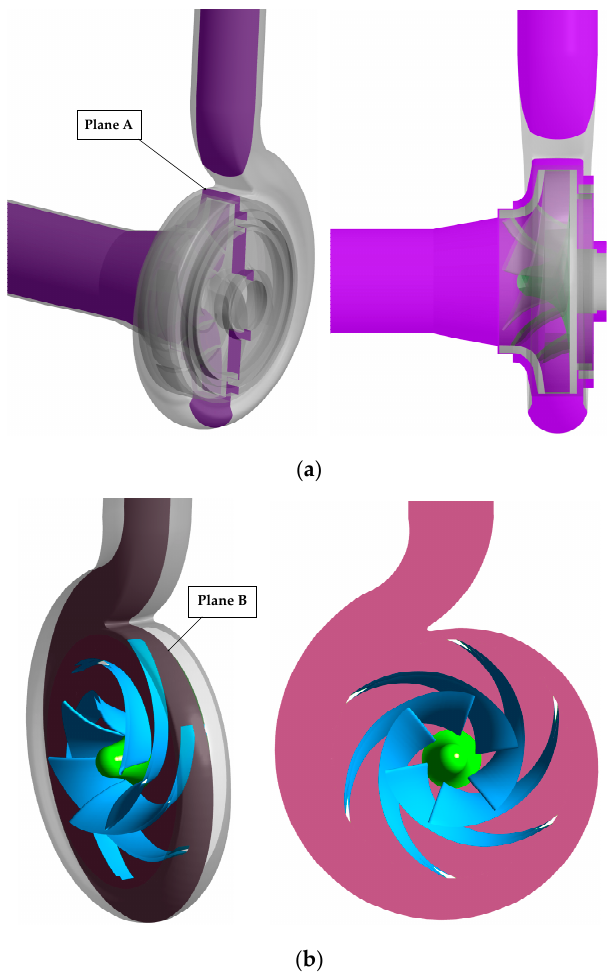
Figure 7. The positions of planes A and B: ( a ) Axial cross-section; ( b ) Intermediate cross-section.